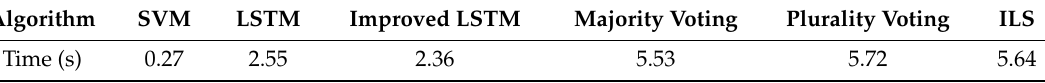
Table 11. Experimental test time for di ff erent prediction